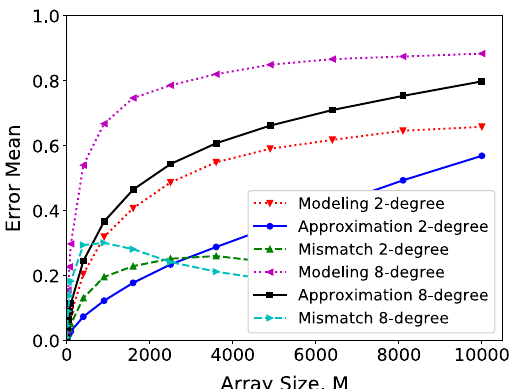
Fig. 5 Modeling error decomposed to approximation error and mismatch error changing with base-station array size. The plot is based on simulated channels with different angle spreads,